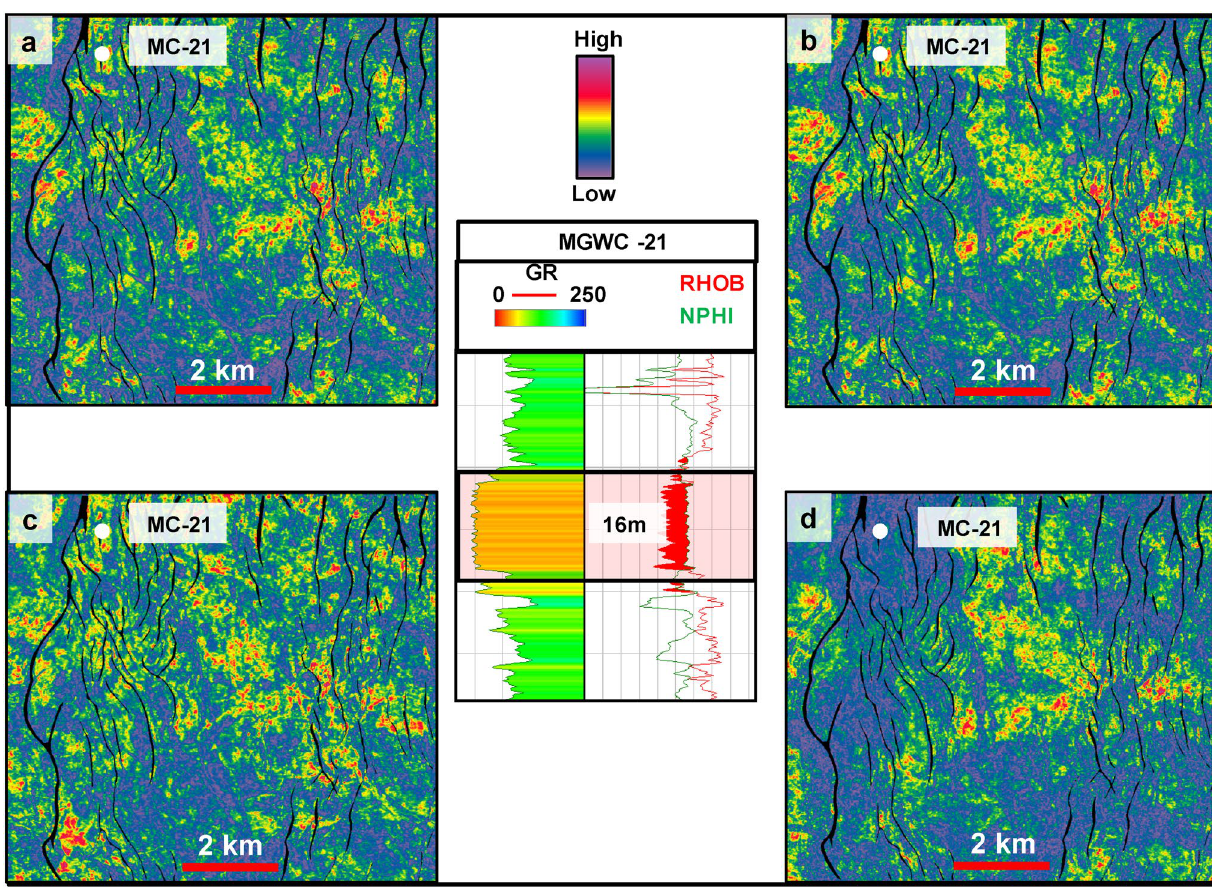
Fig. 10 Spectral decomposition (DFT) gives similar response for 16 m thick sand in horizon K at 20 Hz ( a ) and 45 Hz ( b ) at the well location, whereas CWT gives different responses for 20 Hz ( c ) and